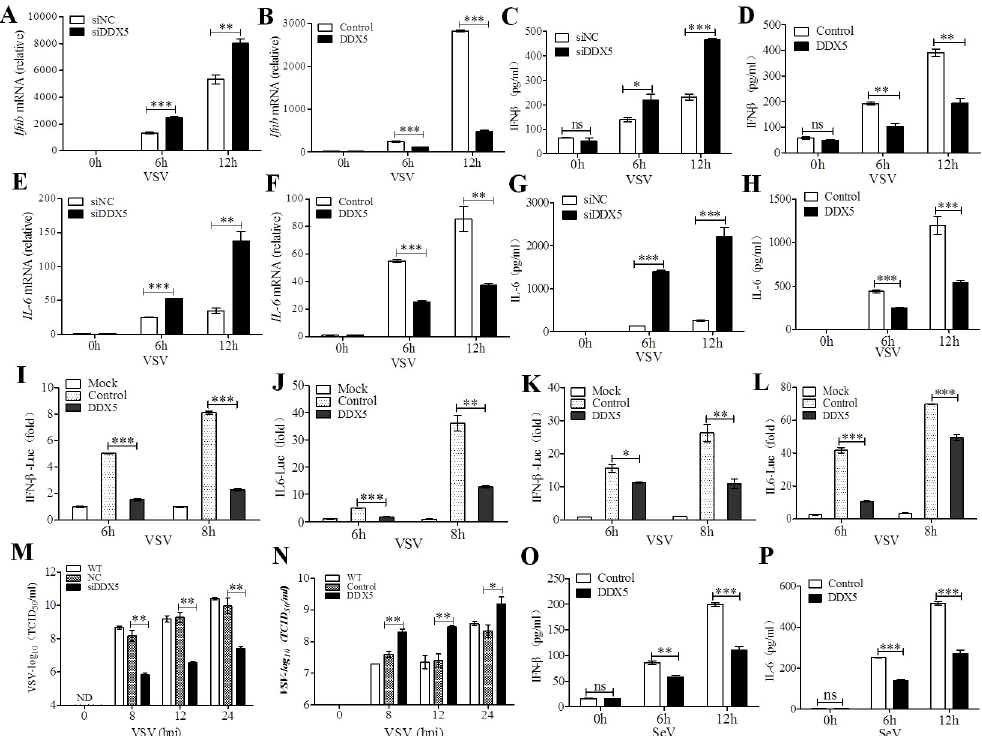
Fig 1. DDX5 promotes VSV replication by suppressing VSV-triggered production of IFN- β and IL-6 in MEFs. (A, B): qRT-PCR of Ifnb mRNA in DDX5-knockdown or -overexpressed MEFs infected with VSV for 0, 6, and 12 h. (C, D): ELISA of IFN- β in the supernatants of DDX5-knockdown or -overexpressed MEFs infected with VSV for 0, 6and 12 h. (E, F): qRT-PCR of IL-6 mRNA in DDX5-knockdown or–overexpressed MEFs infected with VSV for 0, 6, and 12 h. (G, H): ELISA of IL-6 in supernatants of DDX5-knockdown or -overexpressed MEFs infected with VSV for 0,6, and 12 h. (I, J): HEK293T cells were transfected with 500ng IFN- β (I) or IL-6 reporter (J), 20 ng Renilla-TK reporter, and 500 ng plasmid expressing DDX5 or control vector. After 24 h, cells were infected with VSV(MOI = 10). (K, L): MEFs were treated as described in (I, J), the luciferase activity of IFN- β (K) and IL-6 (L) were detected by the DLR Assay System. (M, N): TCID 50 of VSV in DDX5-knockdown (M) or -overexpressed (N) MEFs infected with VSV for 0, 8, 12, and 24 h. (O, P): ELISA of IFN- β and IL-6 in supernatants of DDX5-overexpressed MEFs infected with SeV for 0,6, and 12 h. All data are mean ± SEM of biologically independent samples. Data are representative of three independent experiments. ND, not detected. ns, no significant difference. � p < 0.05, �� p < 0.01, and ��� p < 0.001 (Student’s t -test).